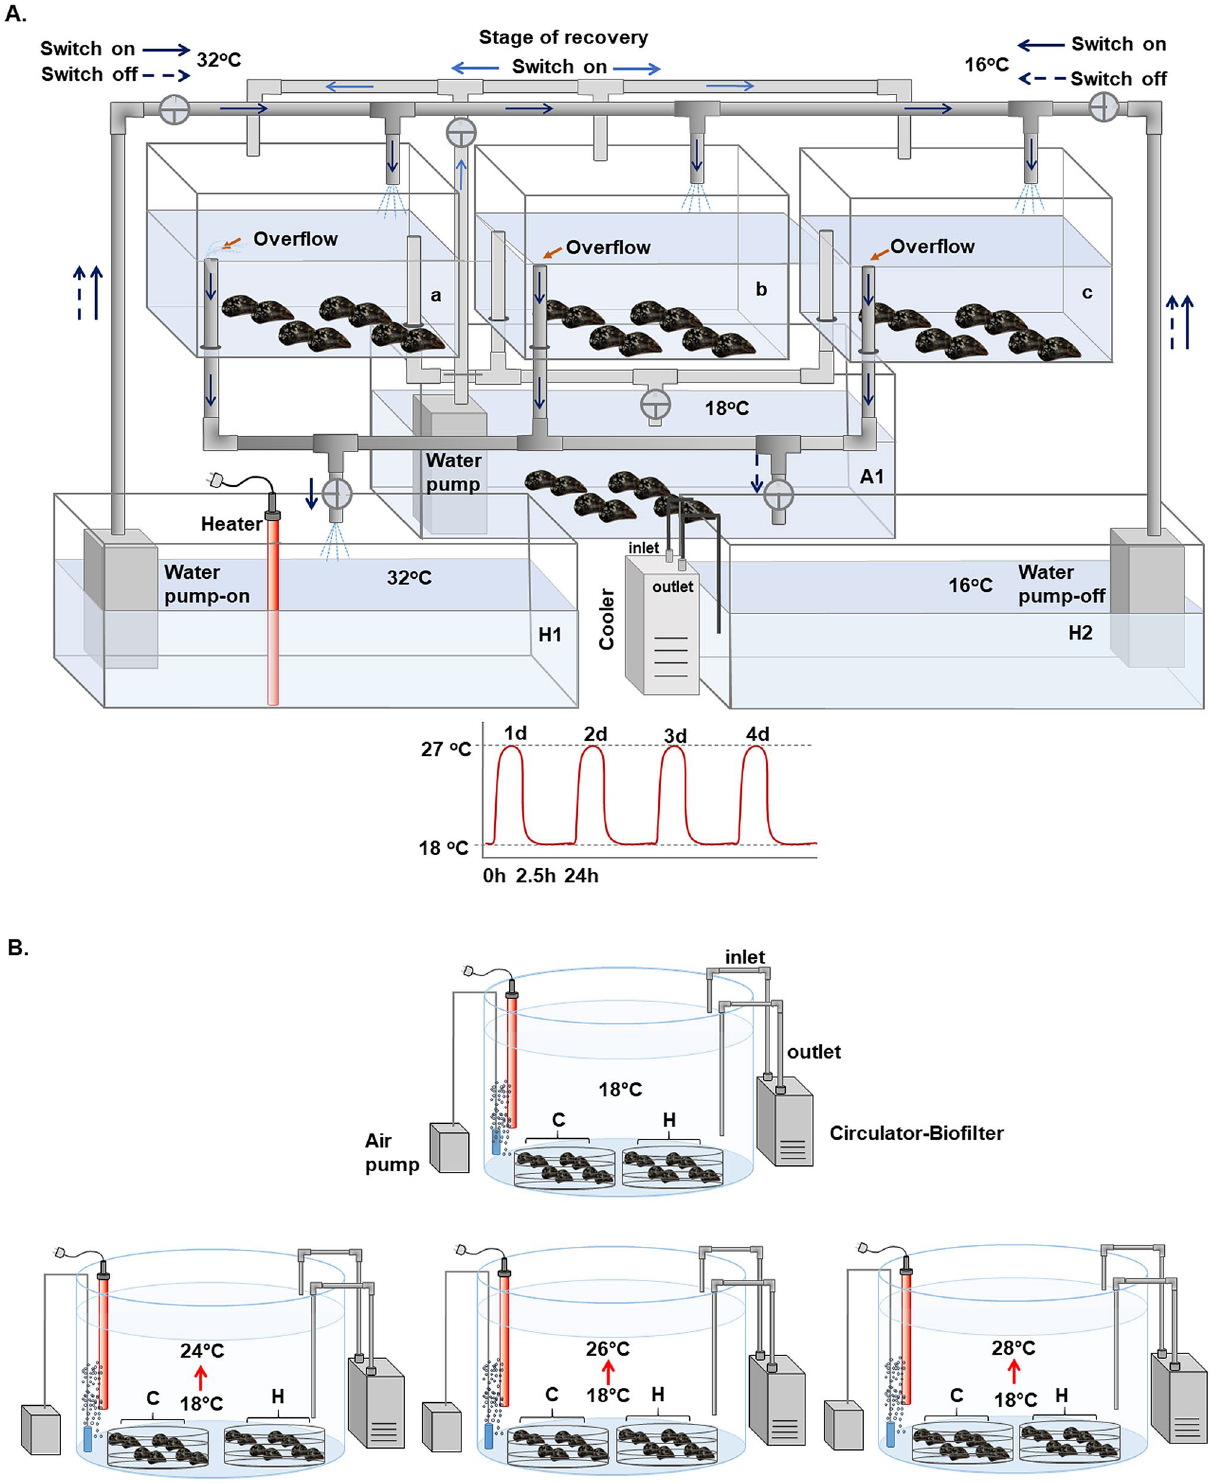
Figure 7. ( A ) Mussels’ hardening phase: tanks with fully aerated water at 18 °C were connected with switches with two other tanks, one with increased (32 °C) and the other with decreased (16 °C) water temperature in order to regulate the water temperature to increased (27 °C) or decreased (18 °C—control) temperatures. ( B ) Mussels’ acclimation phase: transfer of all (hardened and non-hardened) individuals in tanks with recirculating aerated natural seawater at 18 °C and consequent increase at 24 °C, 26 °C and 28